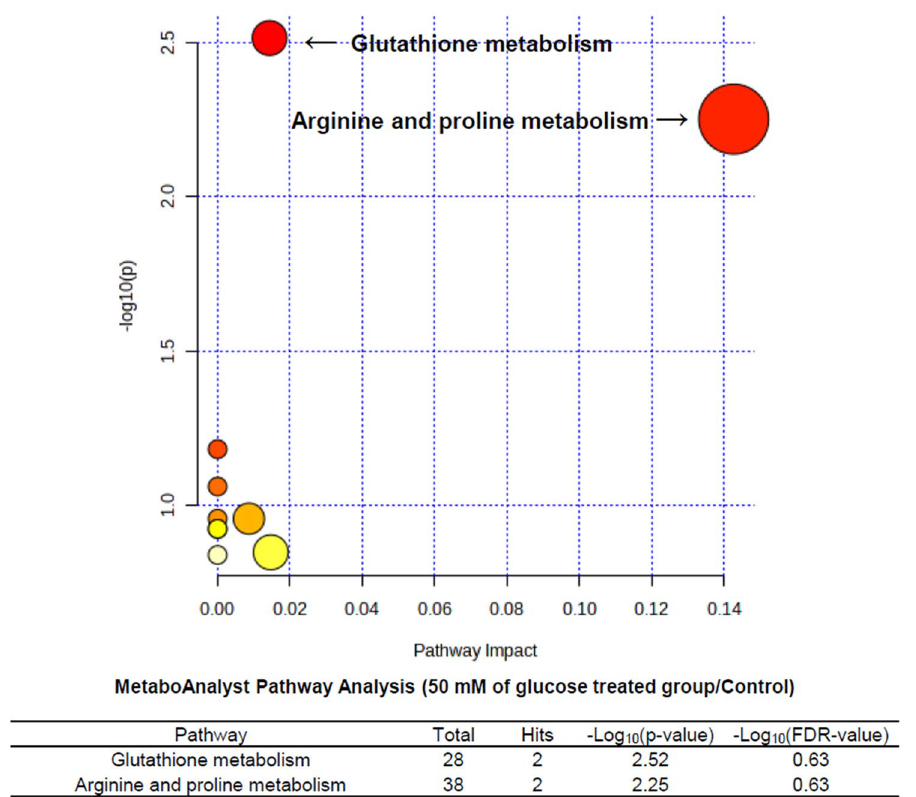
Figure 5. The metabolic pathways analysis for metabolites expressed in tubular epithelial cells treated with 50 mM of glucose compared to those without treatment (control) was performed using MetaboAnalyst. All the matched pathways in KEGG database are displayed as circles. The color and size of each circle represents p value and pathway impact value,